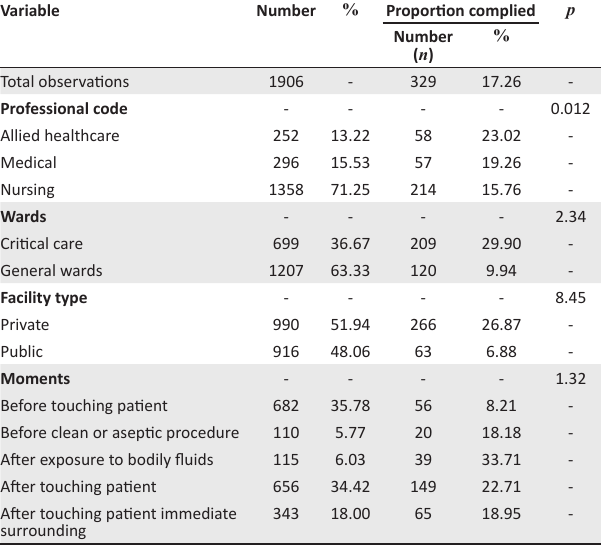
TABLE 3: Level of overall compliance to the five moments of hand hygiene by healthcare professionals.